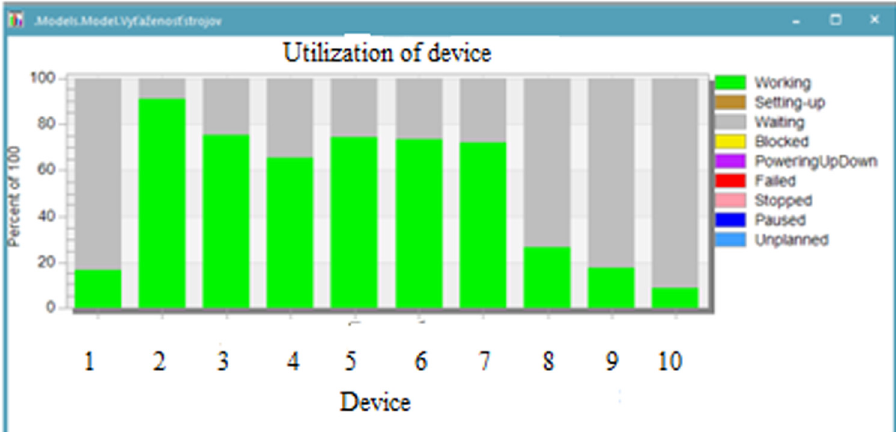
Figure 8: Utilization of devices in the stage “ dryer ” ( 1 – processing, 2 – dryer, 3 – planning, 4 – cutting, 5 – grinding, 6 – drilling, 7 – milling operation, 8 – gluing, 9 – surface treatment, and 10 – package ) . Source: authors.